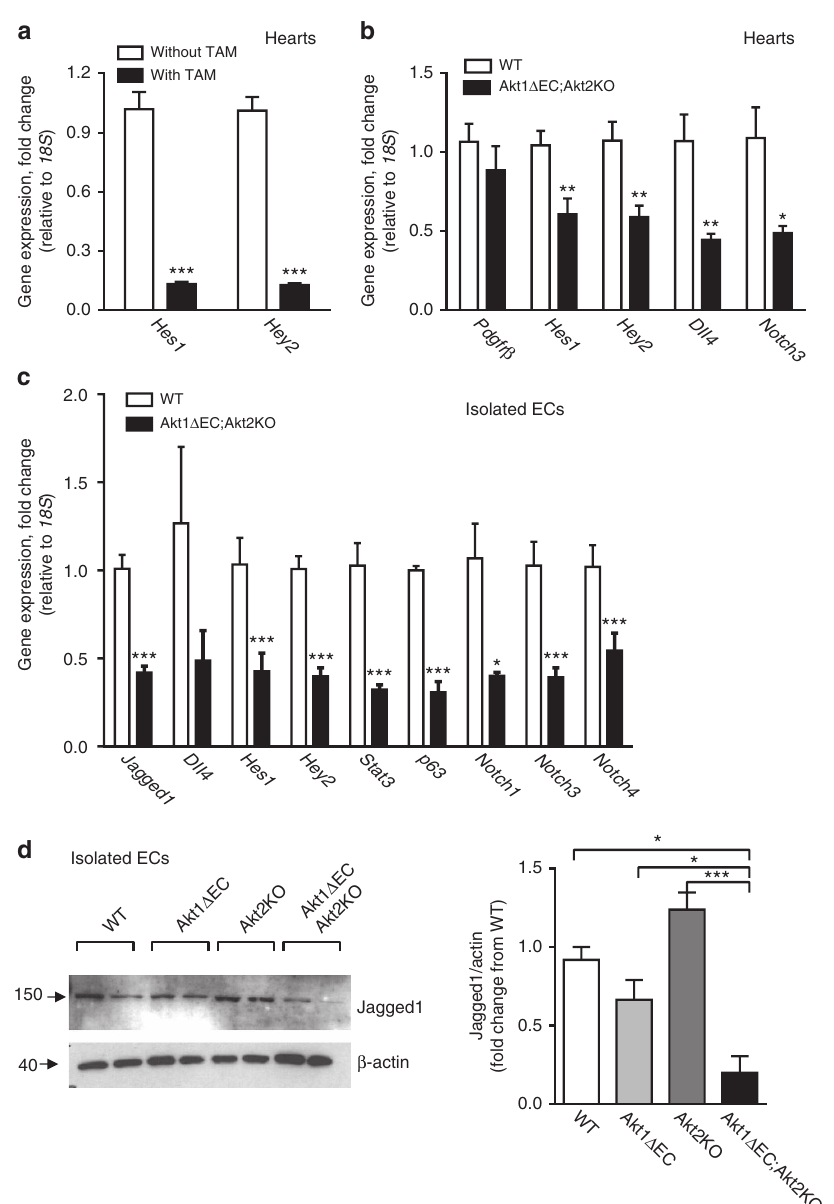
Figure 5 | Notch signalling is diminished by interference with Akt/mTOR pathway. ( a ) Gene expression normalized to 18S in Akt1 D EC;Akt2KO hearts from littermates treated with and without tamoxifen (TAM) for 4 weeks represented as mean fold change from without TAM ± s.e.m. ( n ¼ 3–4). ( b ) Gene expression normalized to 18S in WTand Akt1 D EC;Akt2KO hearts after 4 weeks of tamoxifen treatment represented as mean fold change from WT ± s.e.m. ( n ¼ 3–4). ( c ) Gene expression normalized to 18S in isolated ECs from WTand Akt1 D EC;Akt2KO hearts after 4 weeks of tamoxifen treatment represented as mean fold change from WT ± s.e.m. ( n ¼ 3–4). ( d , e ) Representative immunoblotting and quantification of tamoxifen-treated isolated EC lysates after 3 days of 60ngml (cid:2) 1 VEGF treatment followed by 3 days of 1 m M tamoxifen treatment ( d ), and heart lysates from mice after 4 weeks of tamoxifen treatment ( e ) for actin and Jagged1 represented as mean ± s.e.m. ( n ¼ 2–3). ( f ) Representative immunoblotting and quantification of serum-starved HUVEC lysates after treatment with AktX, rapamycin, LY294002 or wortmannin for 15min (p-Akt, pan-Akt and p-S6) or 24h (p63 and Jag1) in the presence of 20% serum, 50 m gml (cid:2) 1 endothelial growth supplement (ECGS) and 100 m gml (cid:2) 1 heparin represented as mean ± s.e.m. ( n ¼ 2–3). ( g ) Gene expression normalized to 18S in tamoxifen-treated isolated ECs after treatment with AktX or dual antiplatelet therapy (DAPT) for 24h as mean fold change from dimethylsulfoxide (DMSO) control ± s.e.m. ( n ¼ 3–4). ( h ) Gene expression normalized to 18S in serum-starved HUVECs after treatment with AktX, rapamycin, LY294002 or wortmannin in the presence of 20% serum, 50 m gml (cid:2) 1 ECGS and 100 m gml (cid:2) 1 heparin as mean fold change from control ±